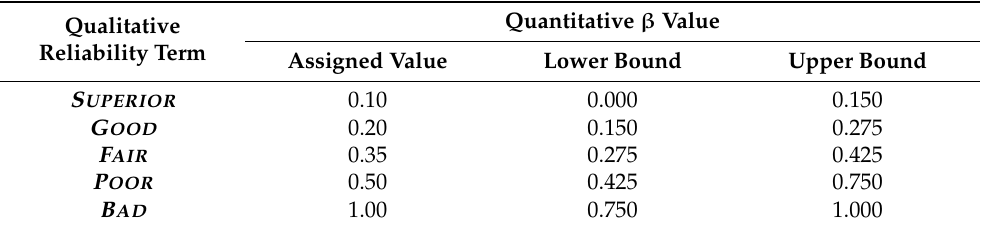
Table 2. Reliability qualitative terminology and their associated uncertainty quantitative values. When a β value has been determined quantitively, we propose to use the numeric bounds for assignment of a qualitative linguistic term for the